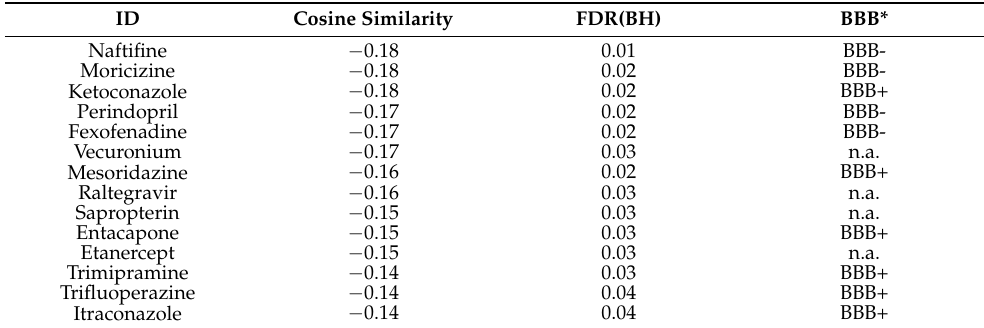
Figure 3. ( A ) Predicted drugs for AD based on anti-similarity; ( B ) similarity matrix for the predicted drugs. Table 2. Predicted drugs for AD, based on anti-similarity.